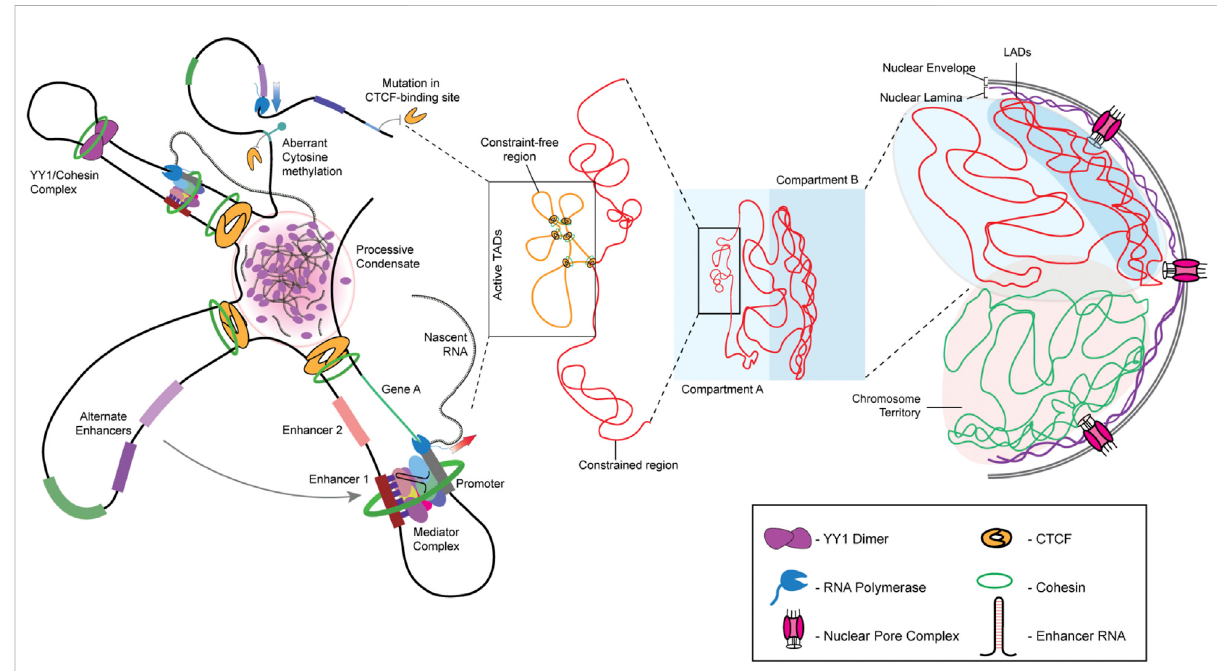
FIGURE 1 Hierarchy of genome organization. The involvement of lamins facilitates LAD organization at the nuclear periphery. Lamins organize the transcriptionally inactive B compartment of the TADs proximal to the nuclear envelope, while the transcriptionally active A compartment is maintained relatively toward the nuclear interior. The promoter-enhancer contacts are maintained by genome organizers such as cohesin, condensin, and CTCF. The presence of multiple such contacts within a TAD allows the formation of splicing